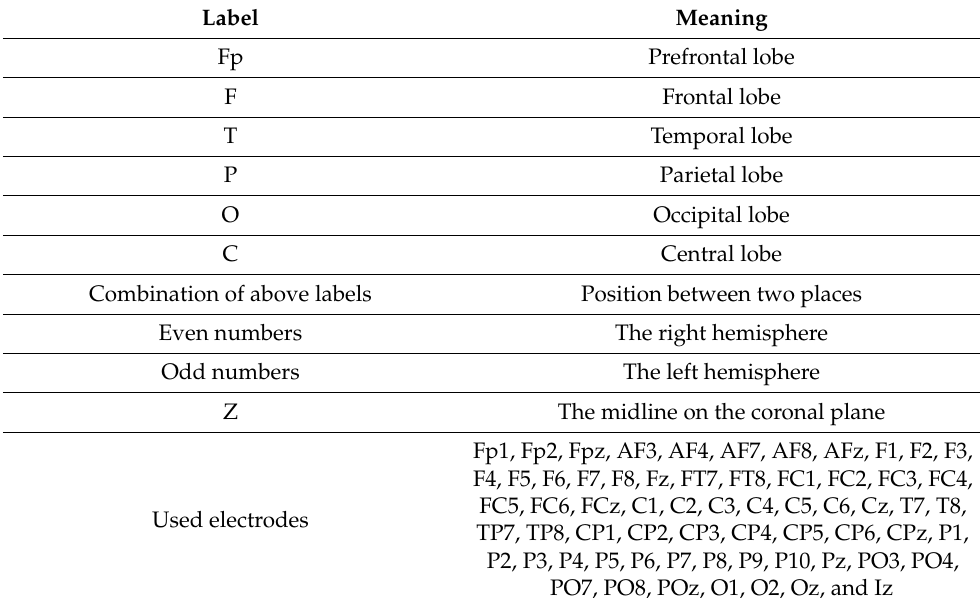
Table 1. Electrodes and description of electrode labels.